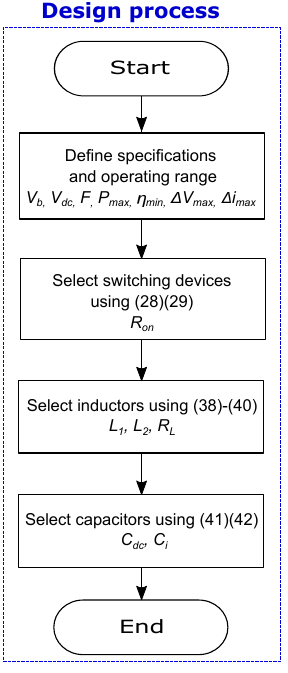
Figure 6. Flowchart of the design